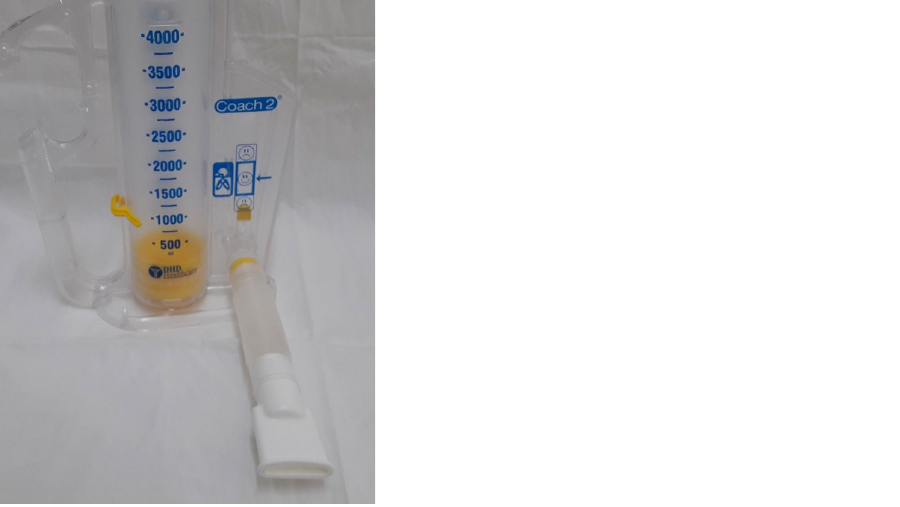
Figure 2. Volume-oriented incentive spirometer (Coach 2